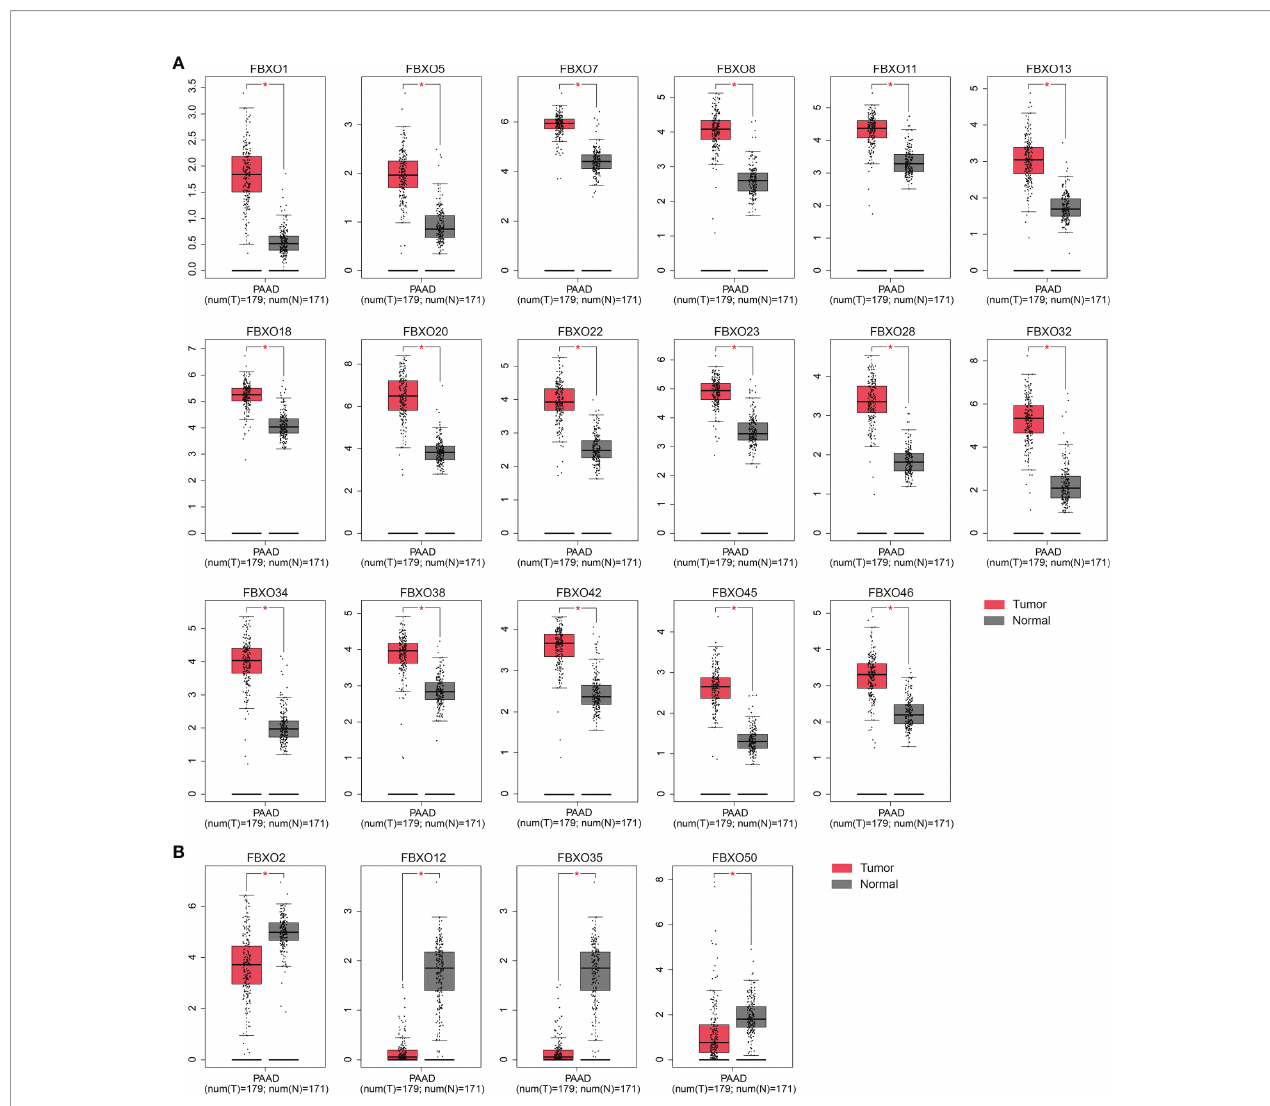
FIGURE 1 | Using GEPIA database, FBXO family members that are aberrantly expressed in pancreatic ductal adenocarcinoma (PDAC) tissues ( n = 179) versus normal pancreatic tissues ( n = 171). (A) FBXO family members that are highly expressed in PDAC tissues. (B) FBXO family members that are lowly expressed in PDAC tissues. * P <